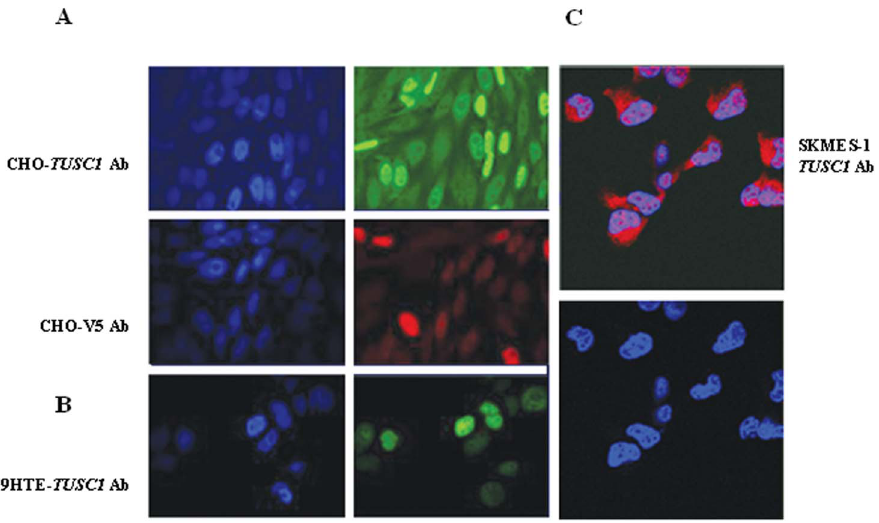
Figure 3. Immunofluorescent staining by confocal microscopy. Localization of TUSC1 in stable transfectants of CHO and 9HTE cell lines. (A) Stably transfected CHO cells were incubated with V5 or TUSC1 antibodies. (B–C) Un-transfected 9HTE and SKEMS-1 lung cancer cells were incubated with TUSC1 antibody. Subcellular distributions of TUSC1 proteins are cytoplasmic and nuclear. V5 antibody was detected with Texas Red-conjugated anti-mouse IgG (Red) and TUSC1 antibody was detected with either Texas Red-conjugated anti-rabbit IgG (Red) or by FITC-conjugated anti-rabbit IgG (Green).